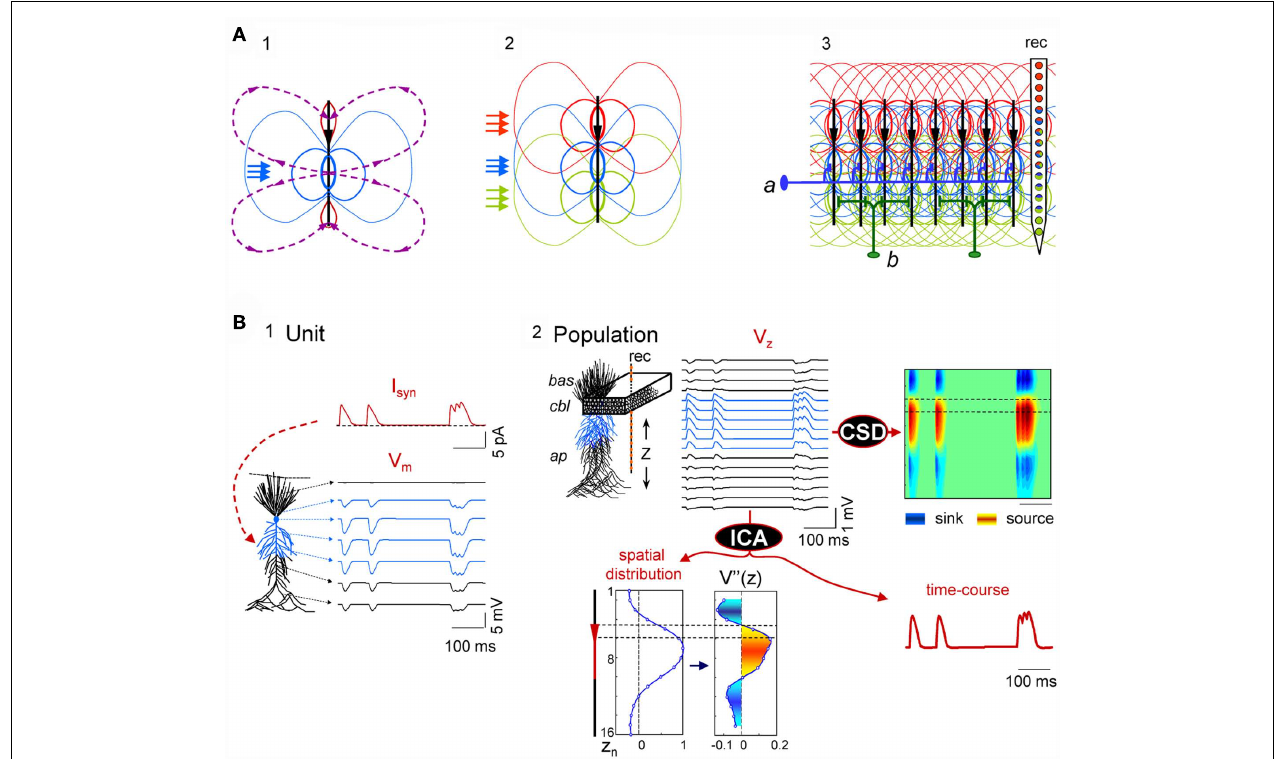
FIGURE 1 | Scaling single neuron currents to macroscopic LFPs and their separation by independent component analysis (ICA). (A) The problem of the mixing of currents in the volume constituting LFPs is simplified in regular structures. A synaptic input to a single neuron (blue arrows in subplot 1) produces quadrupole-like extracellular fields (blue and red isopotential curves) and currents (dashed curves). Due to the spread of currents in the extracellular volume, the field potentials generated by several synapses in different domains overlap strongly (panel 2), but in regular structures with stratified inputs the simultaneous activation of many neurons produce laminar field potentials that are specific for each input (panel 3), and they can be captured by fix groups of electrodes within linear recording arrays (rec). a and b schematically illustrate the multicellular connection of axons from extrinsic neurons and local interneurons, respectively. (B) An irregular series of inhibitory synaptic currents (panel 1, unit , I syn ) is injected to a dendritic band